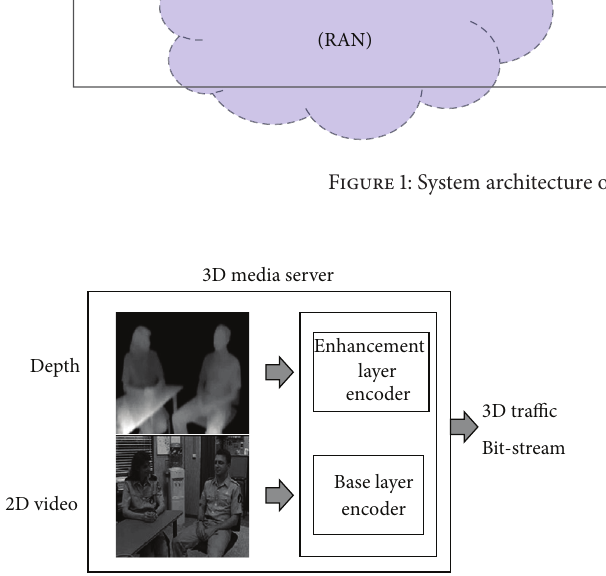
Figure 2: Layered coding approach of video-plus-depth 3D video.